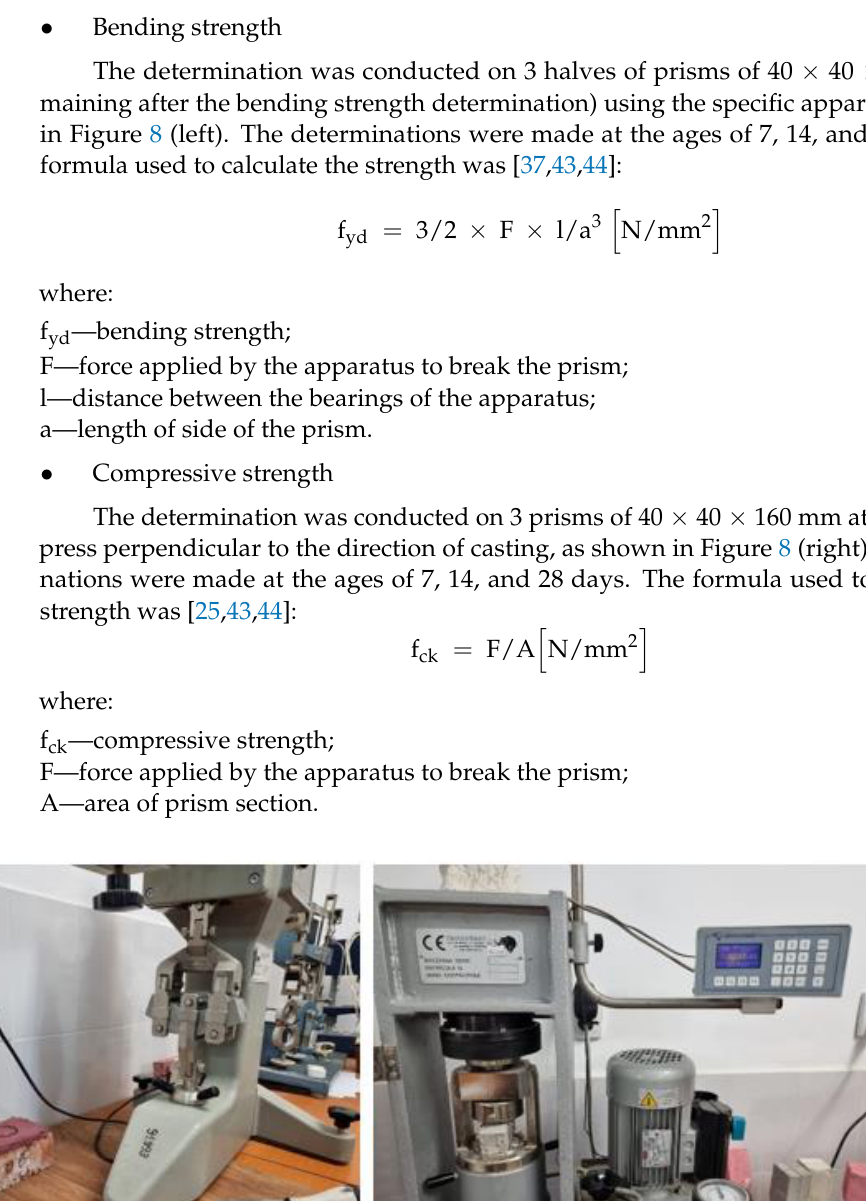
Figure 9. Apparatus for testing adhesion to the support layer.